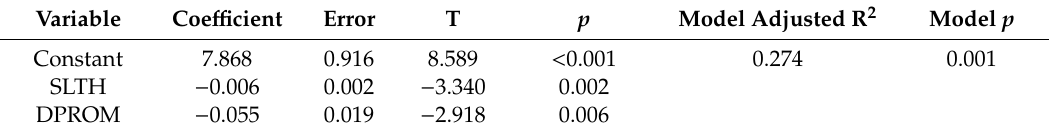
Table 7. RegressiontableforstepwisemultiplelinearregressionanalysisfornGRFzfrompredictorvariables.